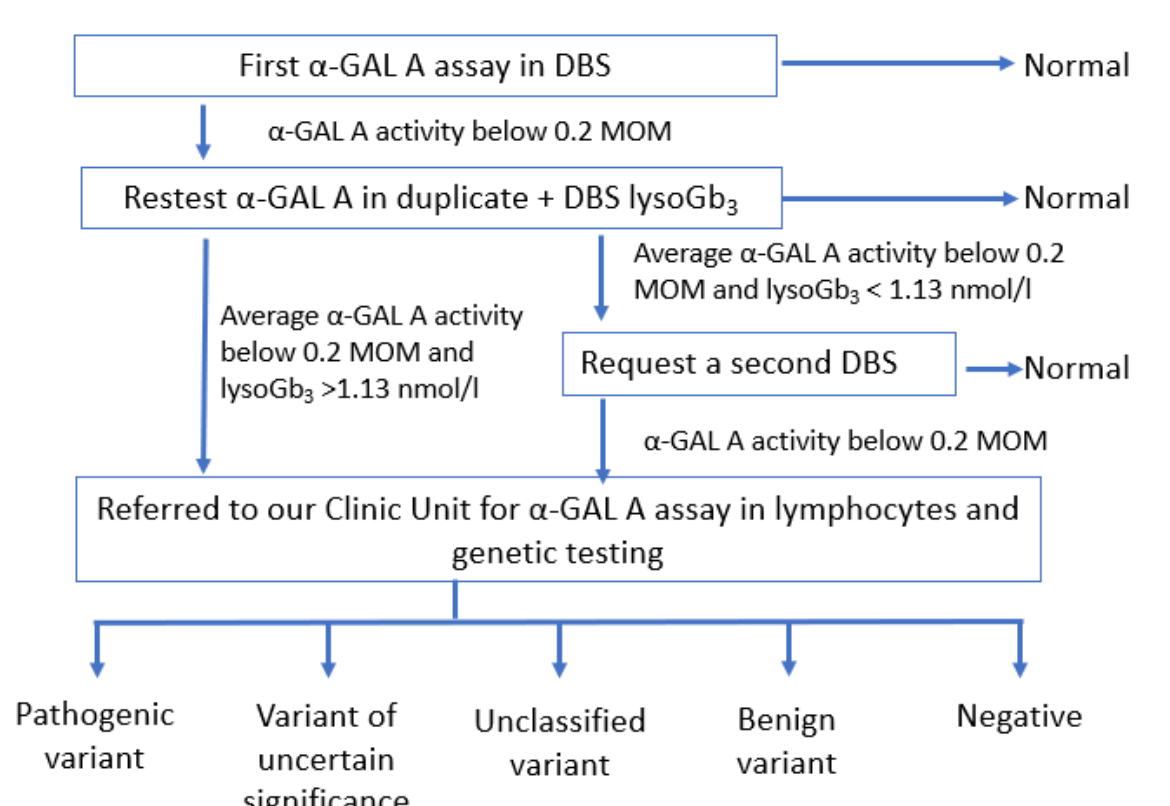
Figure 2. Proposal for a diagnostic algorithm of male newborn screening for Fabry disease. MOM: multiple of median; DBS: dried blood spot.